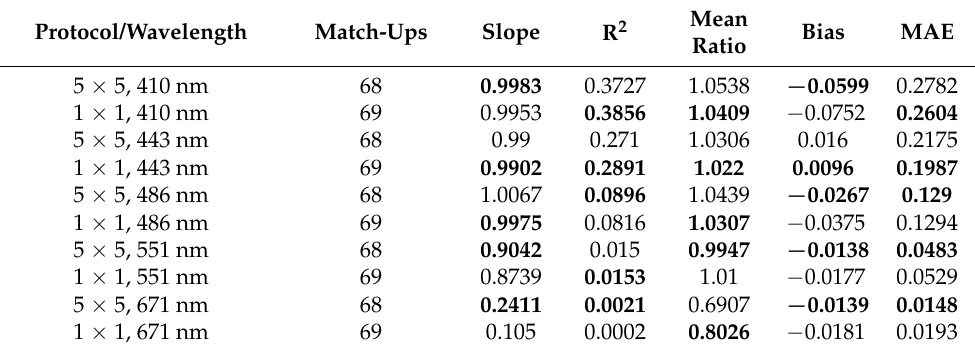
Table 9. MOBY data, June 2014 − May 2019. Strict data protocol at 5 × 5 and 1 × 1 box sizes. Values closest to one in bold, for slope, R 2 , and mean ratio. Lowest values in bold for bias and mean absolute error.